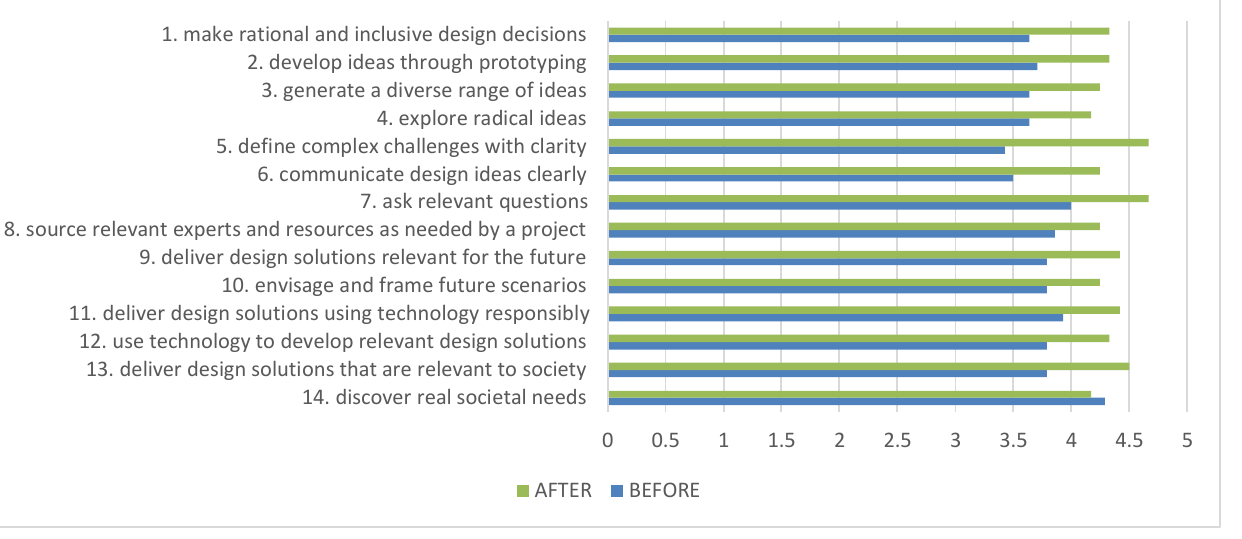
Fig. 5. Before and After Self-efficacy results for all questions